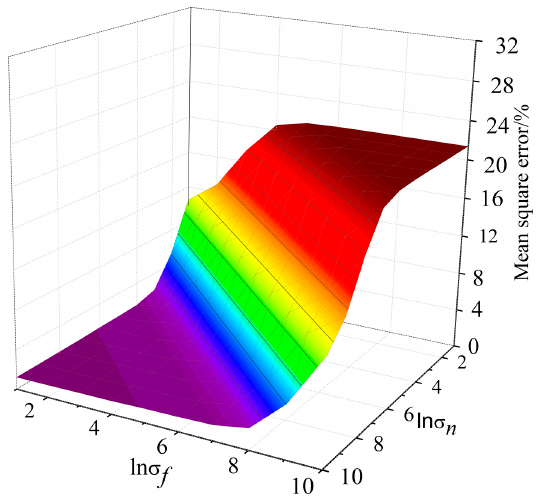
Figure 9. The influence of GP parameters on the prediction accuracy.